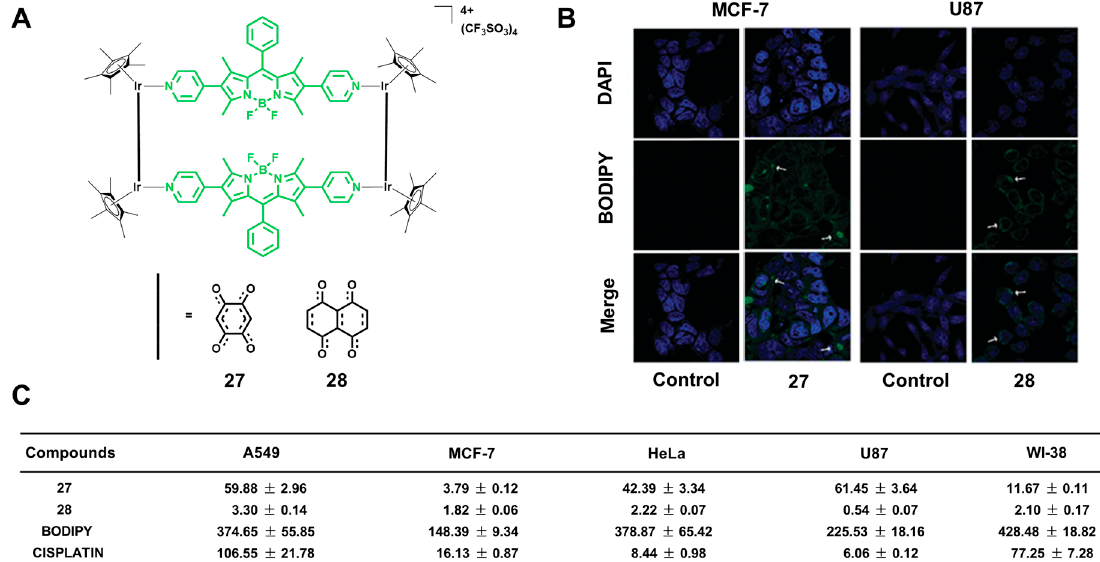
Figure 11. ( A ) Chemical structures of complexes 27 and 28 . ( B ) Left: MCF-7 cells treated with 1 mM 27 . Right: U87 cells treated with 0.75 mM 28 . ( C ) IC 50 ( μ M) of 27–28 , BODIPY and cisplatin in different cell lines. Reprinted with permission from [72] , copyright 2016, Royal Society of Chemistry.